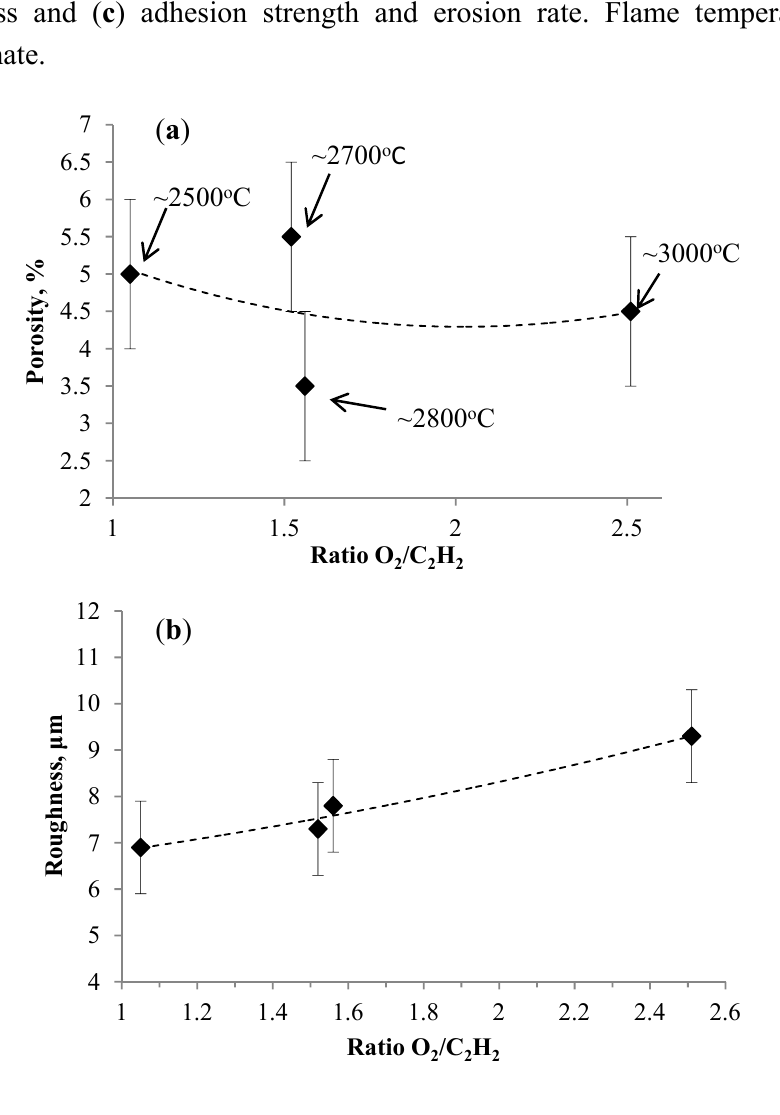
/C H ratio: ( a ) porosity; 2 2 2